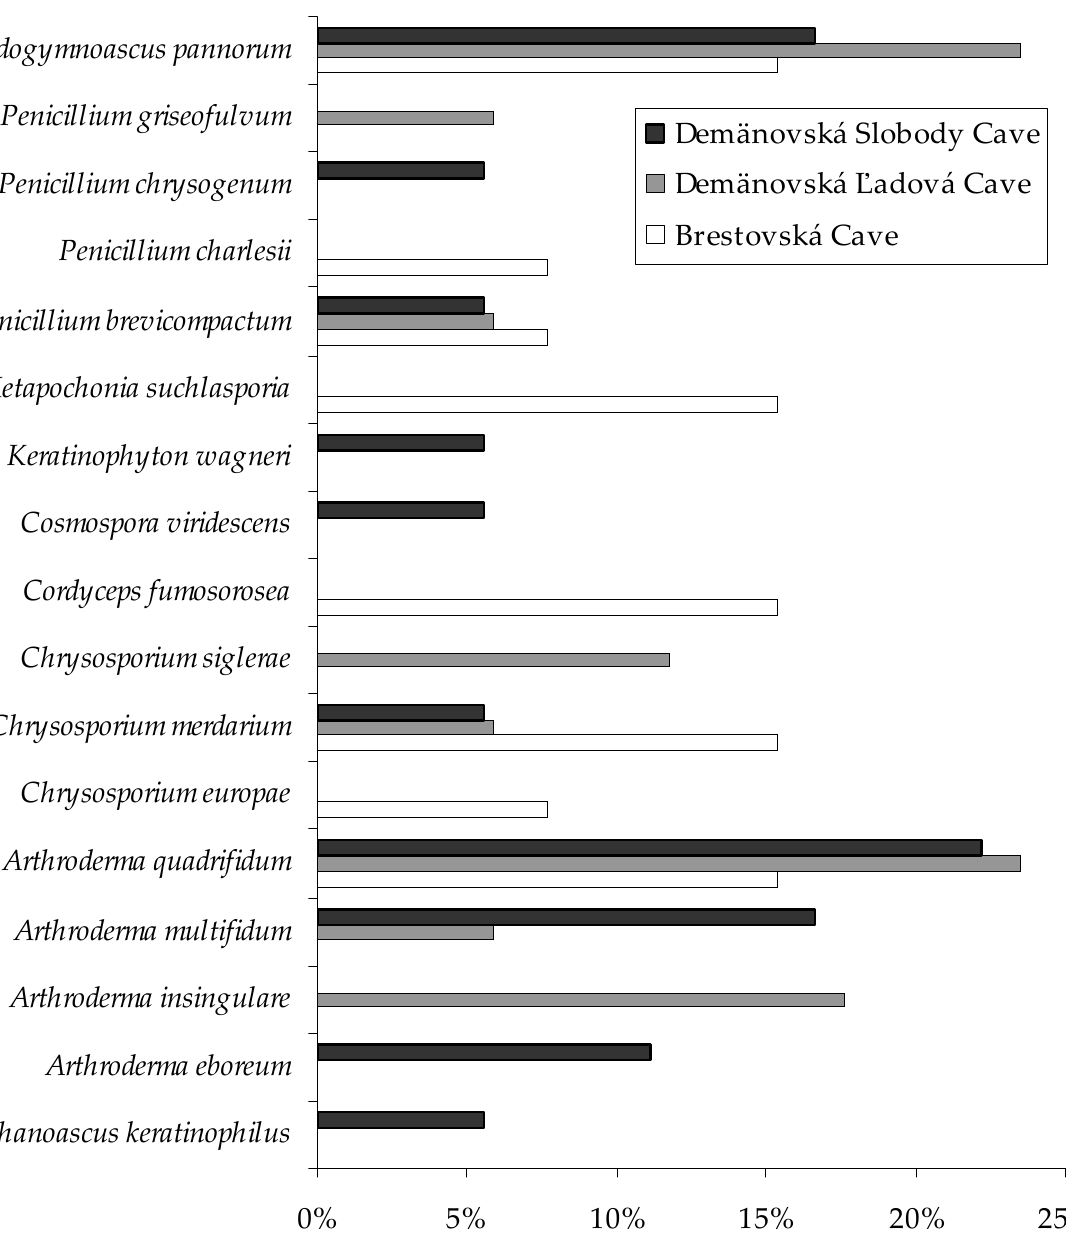
Figure 3. The percentage contribution of each isolate from the soil/sediment samples to the total from particular caves for the interior study sites.